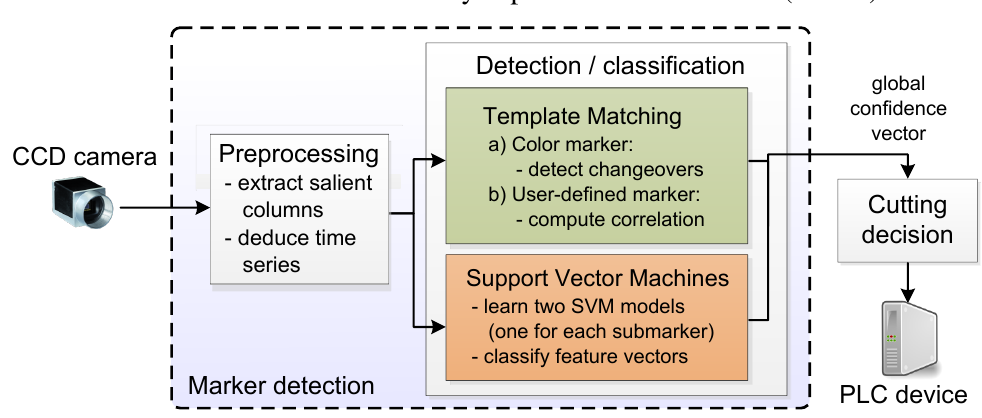
Figure 8. Pipeline of the vision based marker detection system (dashed boxes in Figure